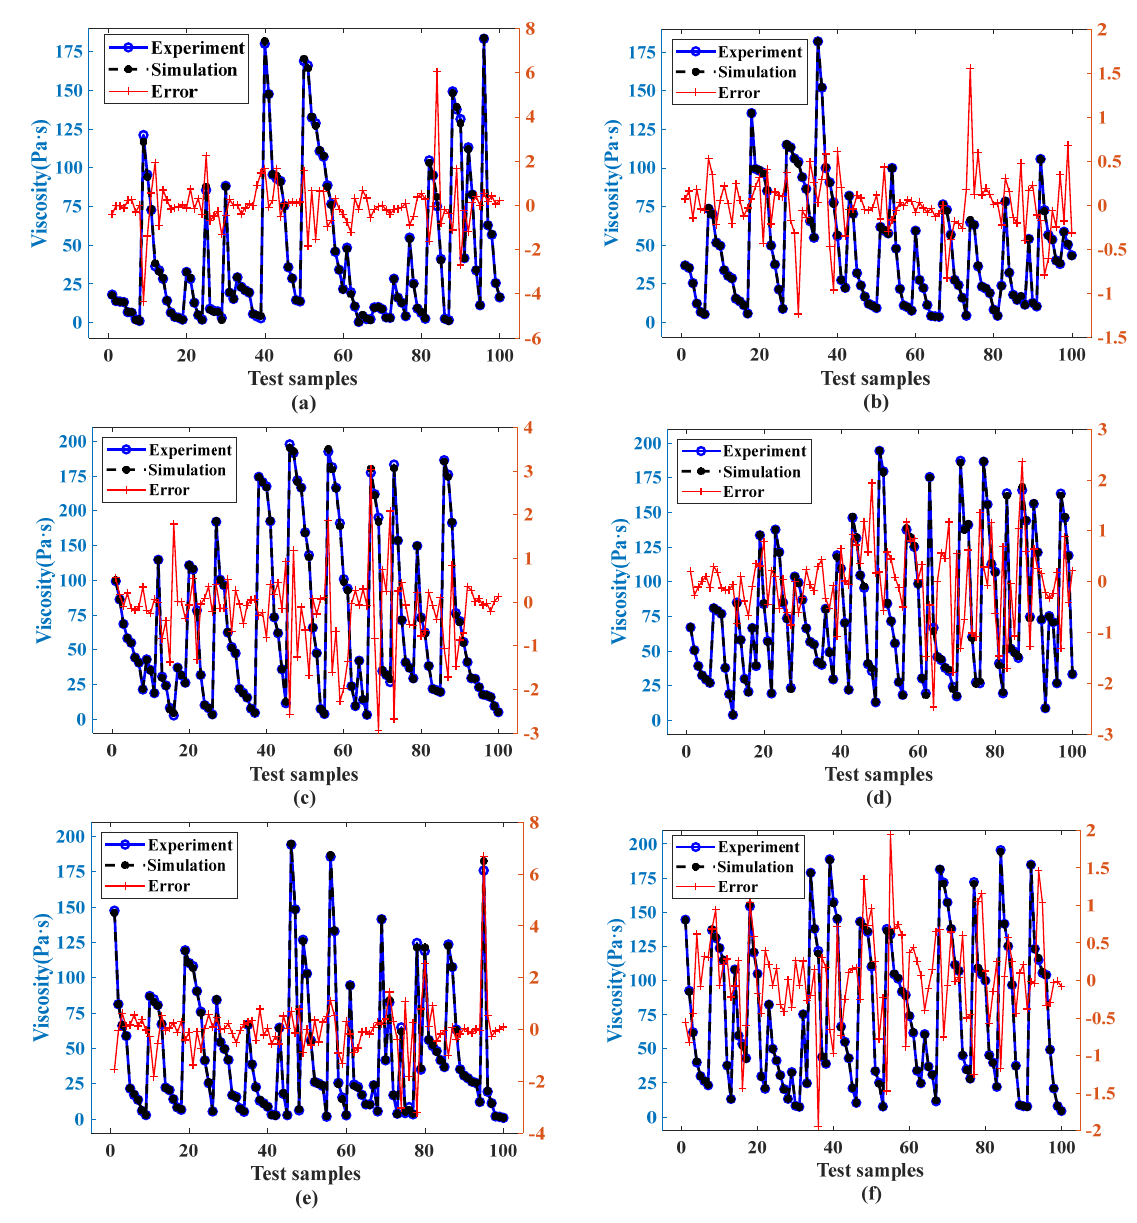
Figure 2. Prediction errors for the different prediction models: ( a ) model 1; ( b ) model 2; ( c ) model 3; ( d ) model 4; ( e ) model 5; ( f ) model 6.